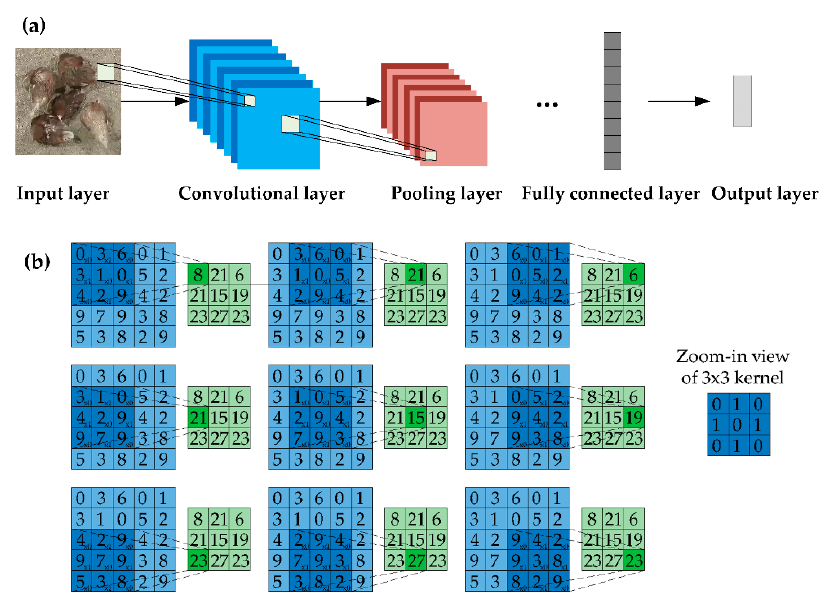
Figure 4. Example illustrations of ( a ) a convolutional neural network and ( b ) a convolution with kernel size of 3 × 3, stride of 1, and no padding.